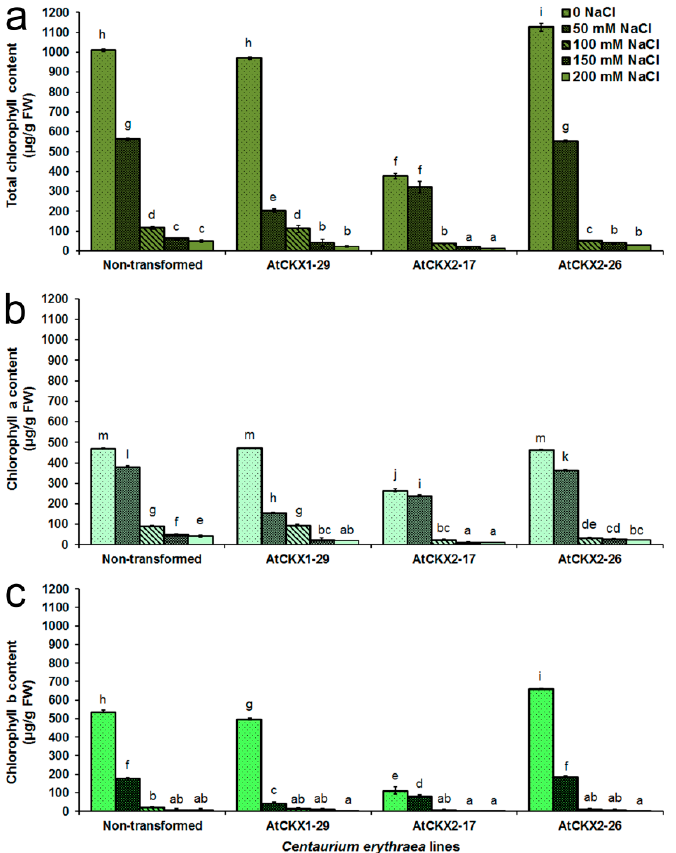
Figure 2. Total Chl ( a ), Chl a ( b ), and Chl b ( c ) contents in the shoots of non-transformed and transgenic centaury lines ( AtCKX1 -29, AtCKX2 -17, and AtCKX2 -26) after 8 weeks of growth on 1 / 2 MS medium supplemented with 0-, 50-, 100-, 150-, and 200-mM NaCl. The data represent the mean ± standard error. Means marked with a different letter are significantly different from the control, according to the LSD test ( p ≤ 0.05).